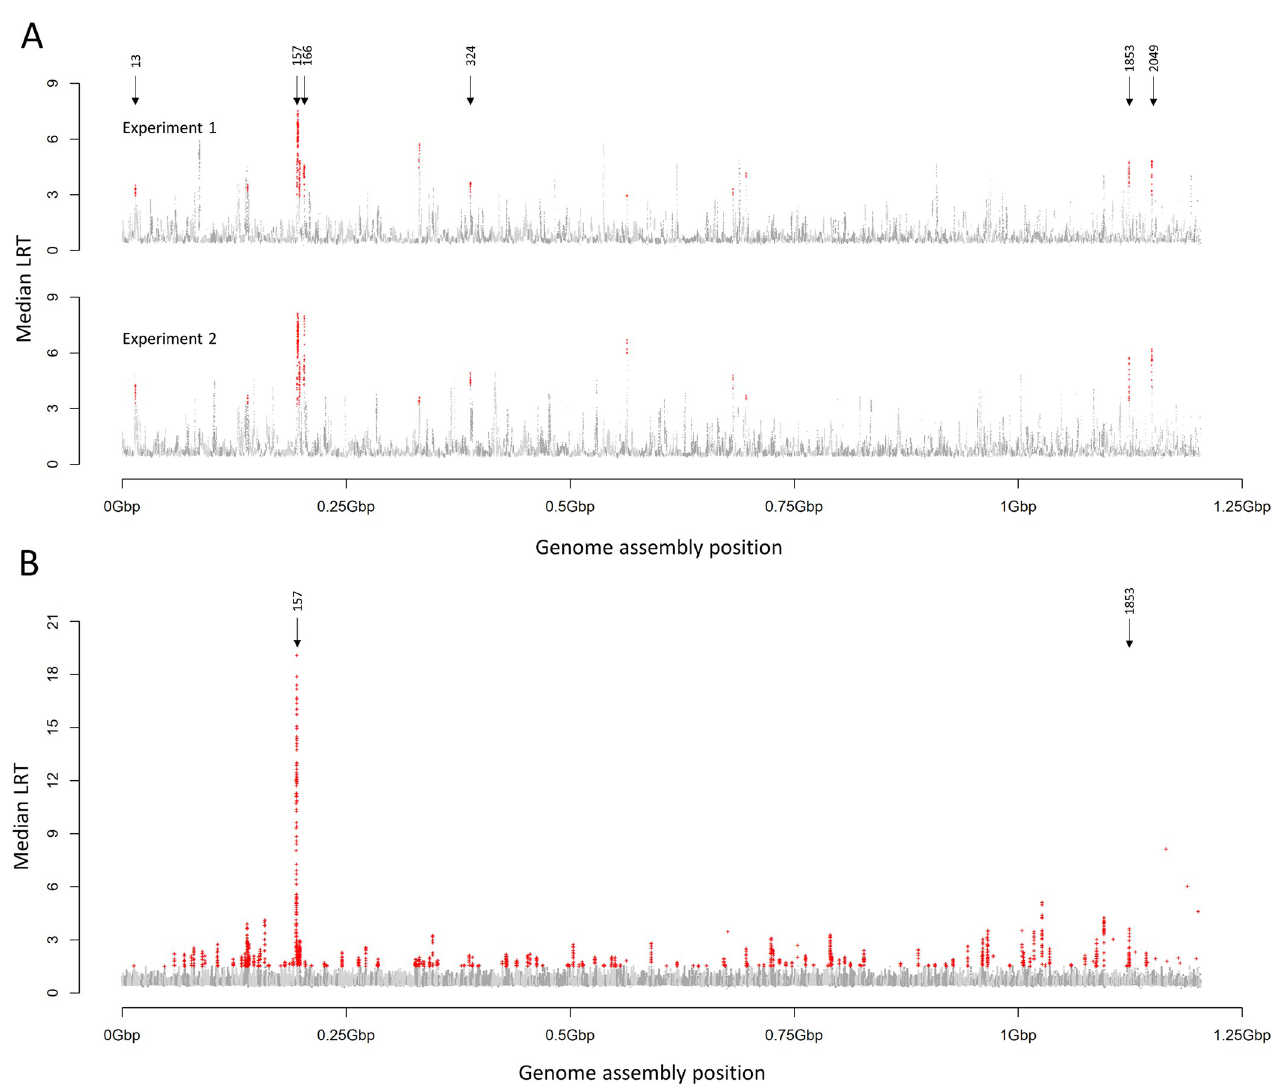
Fig 2. Genome scan for regions associated with resistance to triclabendazole. Data show the median likelihood ratio test (LRT) statistic from generalised linear models within moving windows of 1000 informative SNPs. Scaffolds are represented in alternating dark grey and light grey to allow visualisation. Scaffold order on the x-axis is arbitrary and does not imply physical proximity. (A) Results of the two replicate crossing experiments. Position of scaffolds under greatest selection (13, 157, 166, 324, 1853 and 2049) is indicated by arrows. Red crosses indicate where the median LRT appears in the top 1% quantile in both experiments. (B) Results from Field Isolate 1. Position of scaffold 157, under greatest selection, and scaffold 1853 are indicated by arrows. Red crosses indicate where the median LRT appears in the top 1% quantile.